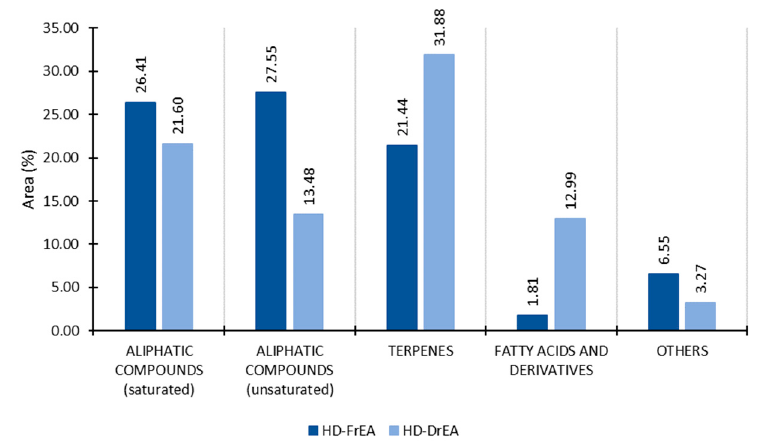
Figure 8. The volatile organic compounds (VOCs) of E. amentacea obtained by HD, analysed by GC-MS, and sorted by structural groups. HD-FrCC—hydrodistillate of fresh E. amentacea ; HD-DrCC— hydrodistillate of air-dried E. amentacea . Table 4. The VOCs from E. amentacea isolated by HD and analysed by GC–MS: (XI—hydrodistillate